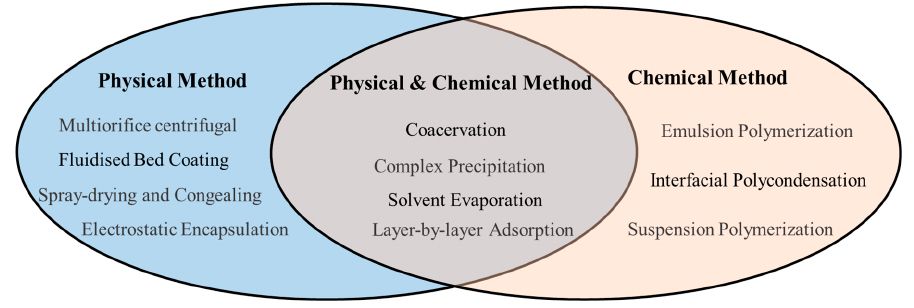
Figure 1. Major microencapsulation methods.